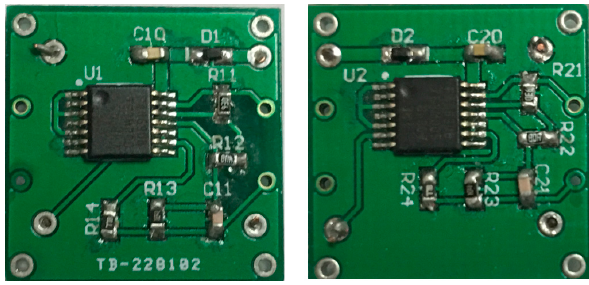
Figure 14. The printed circuit board (PCB) with two oscillating circuits.